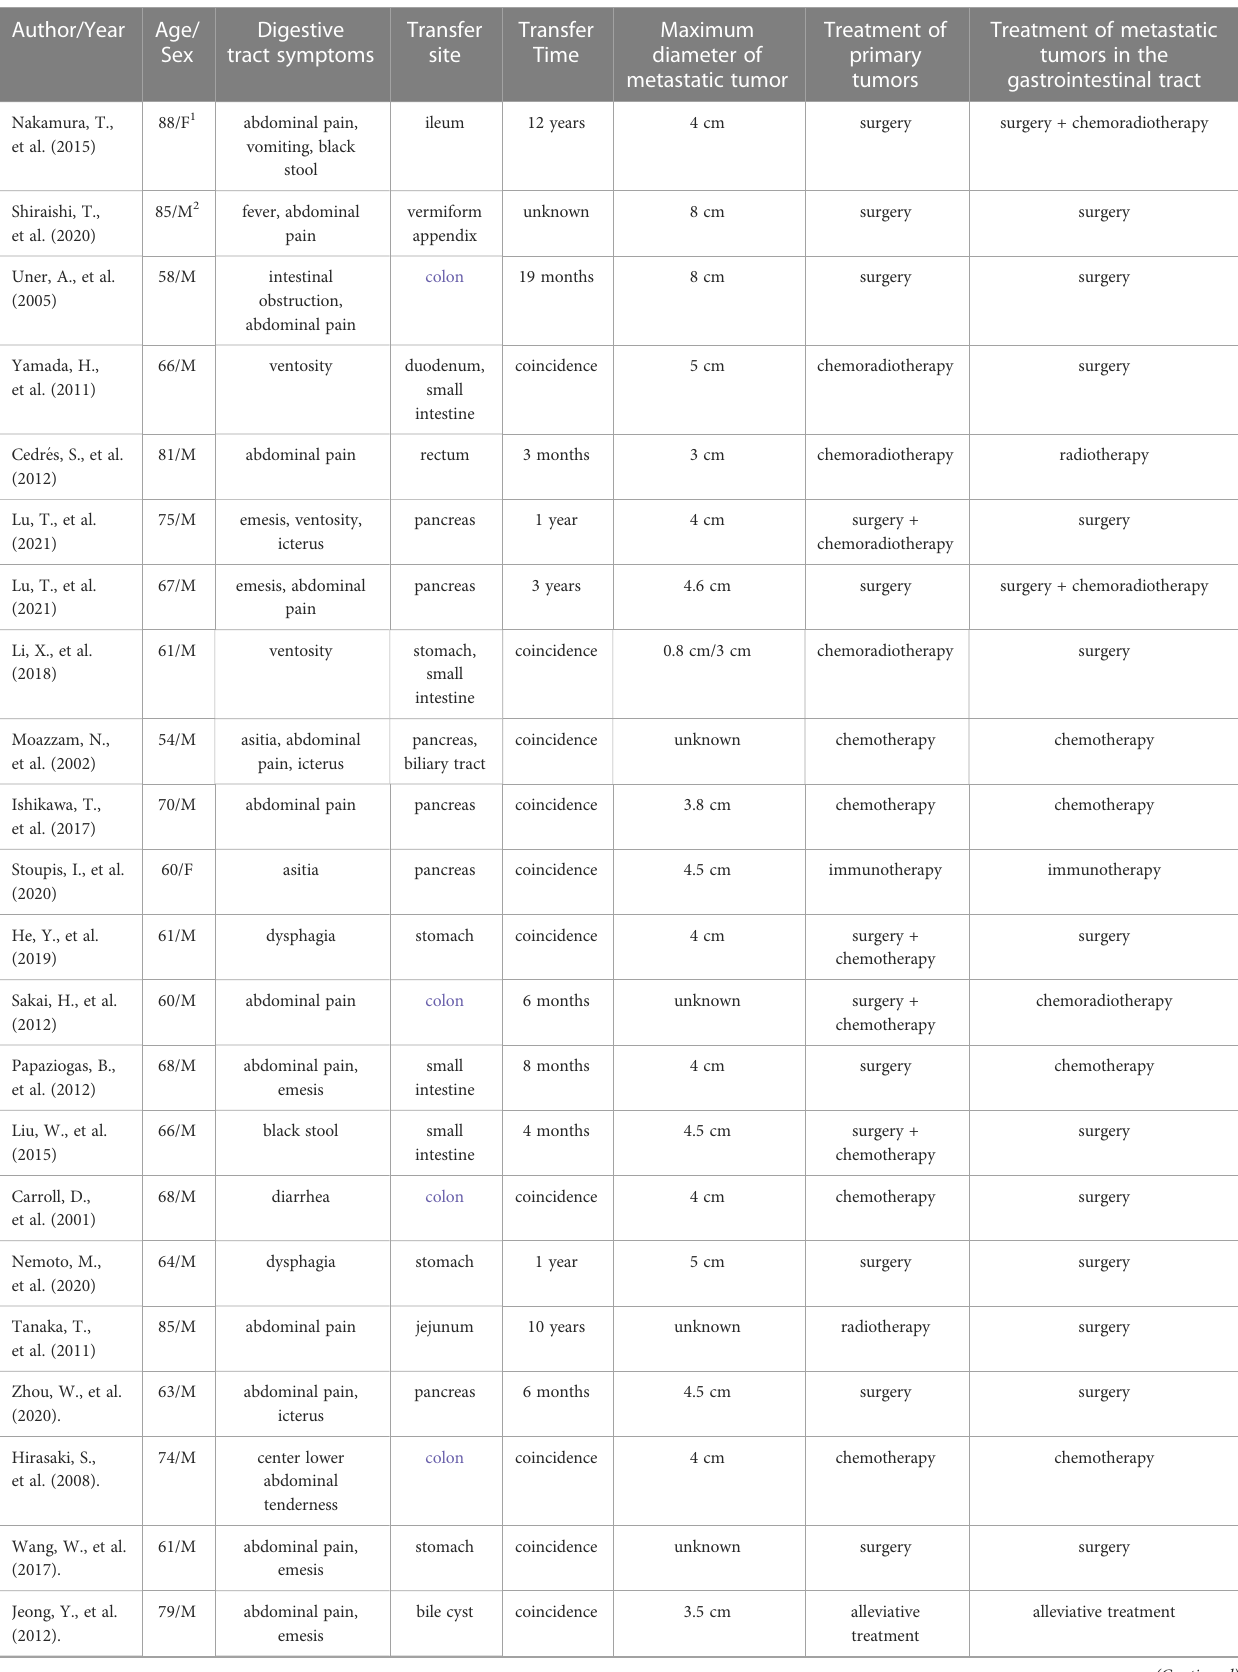
TABLE 2 The previously reported lung squamous cell carcinoma with gastrointestinal